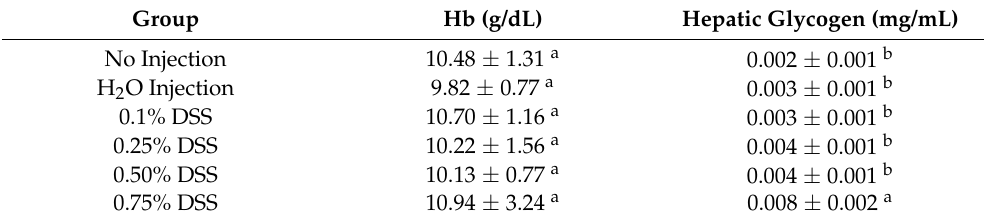
Table 4. Blood hemoglobin (Hb) concentrations (g/dL) and hepatic glycogen levels (mg/mL). Group